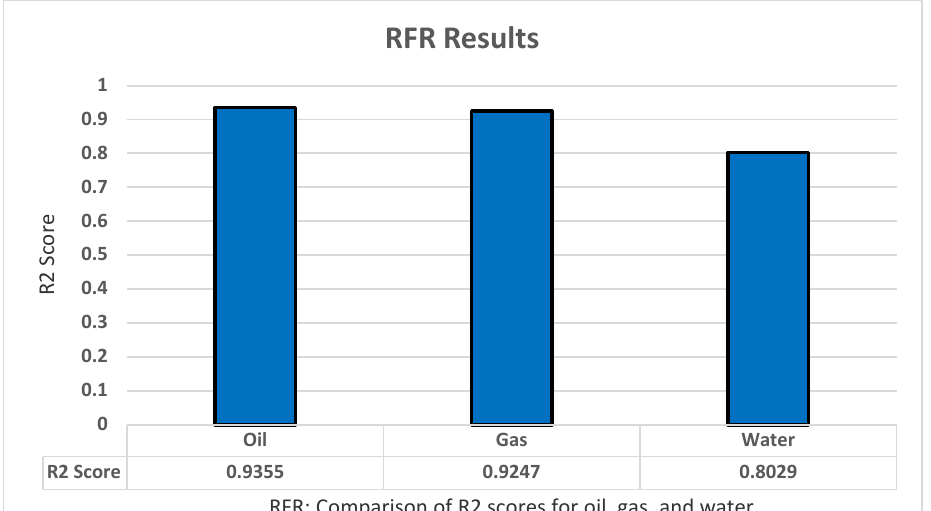
RFR: Comparison of R2 scores for oil, gas, and water Figure 8. RFR’s R2 score results.